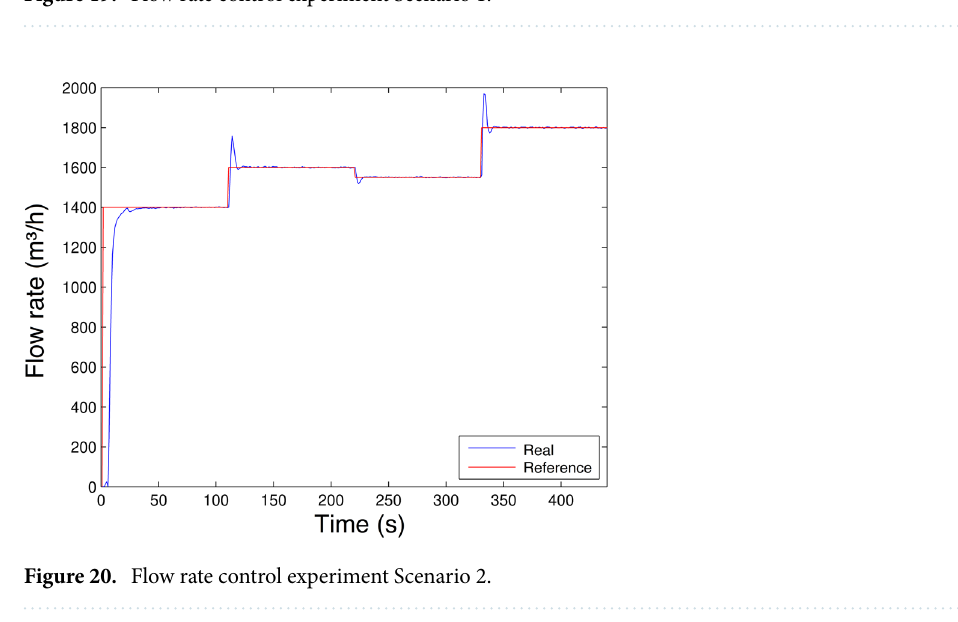
Figure 19. Flow rate control experiment Scenario 1.